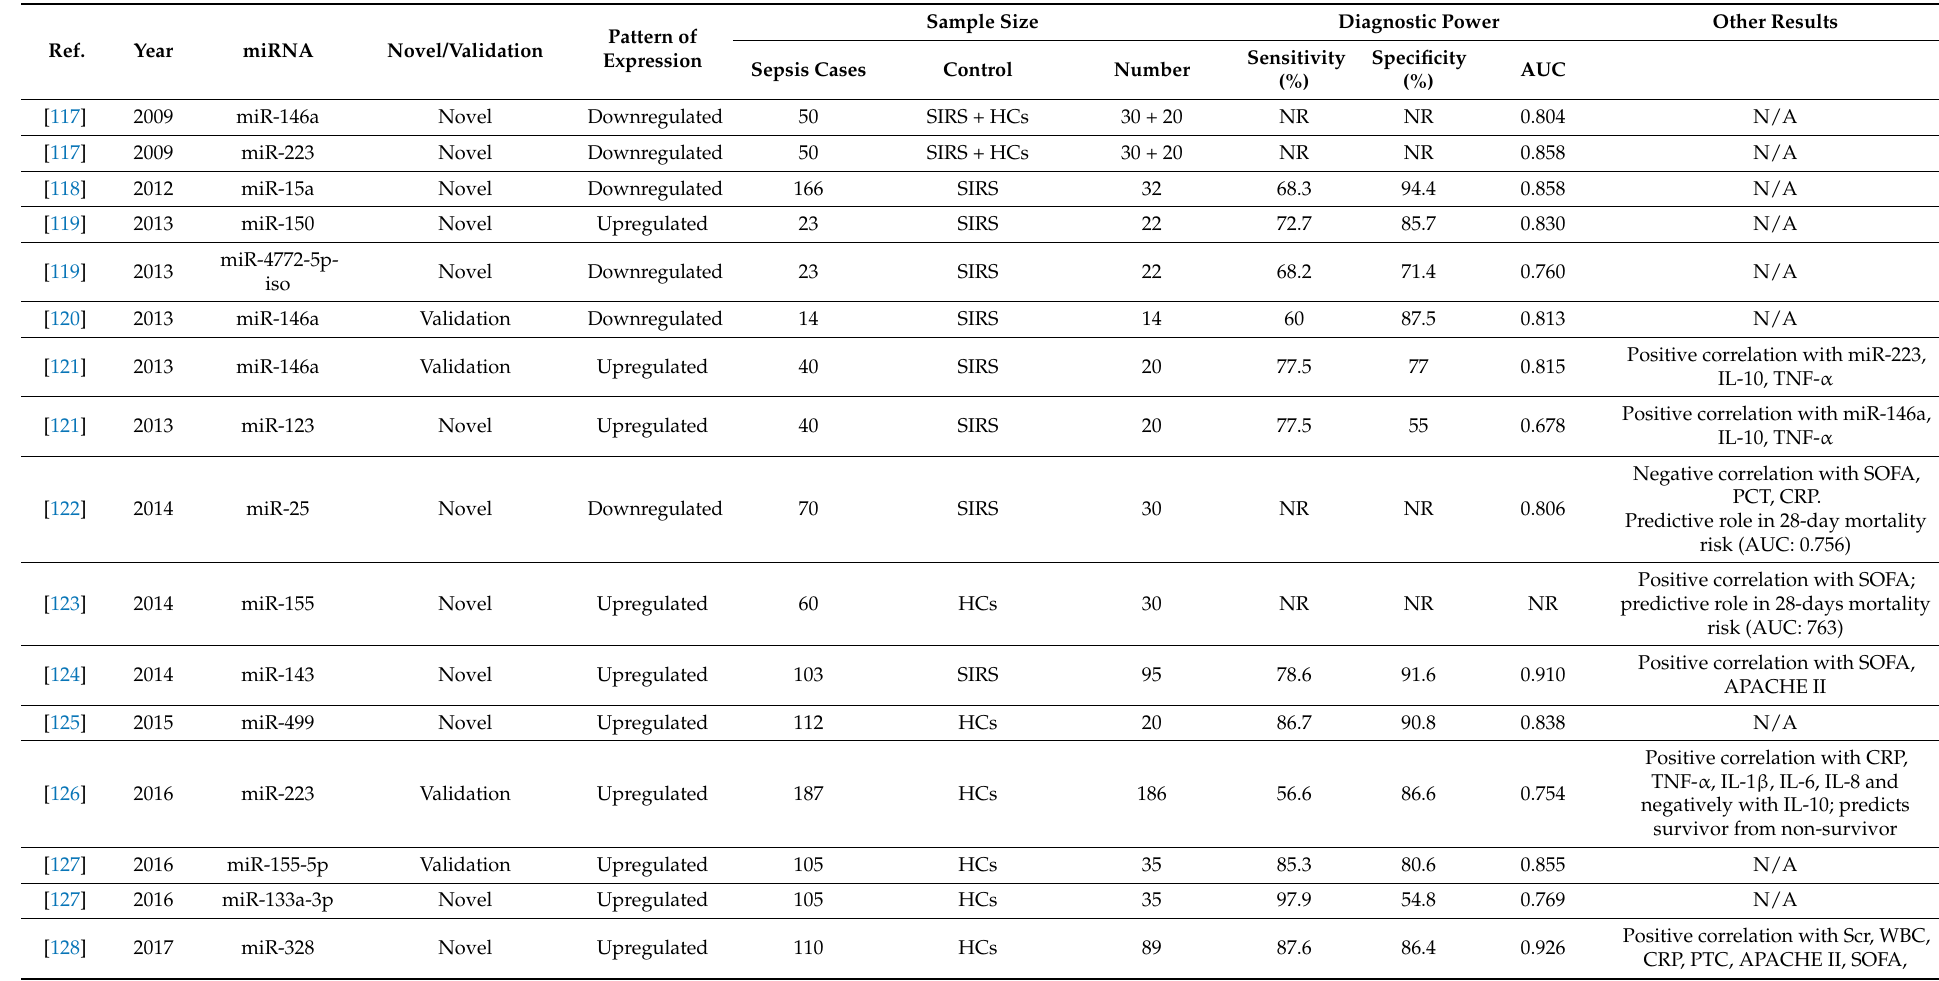
Table 2. Main findings of the study regarding miRNA addressing the issue of their reliability as biomarkers and prognostic tools in clinical settings of sepsis in